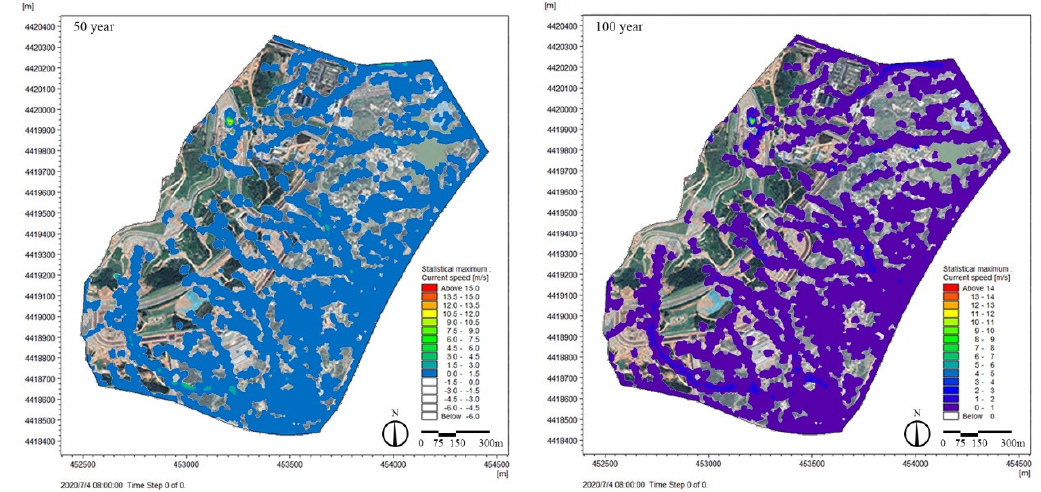
Figure 12. Changes in current speed under rainfall in different return periods before and after construction.